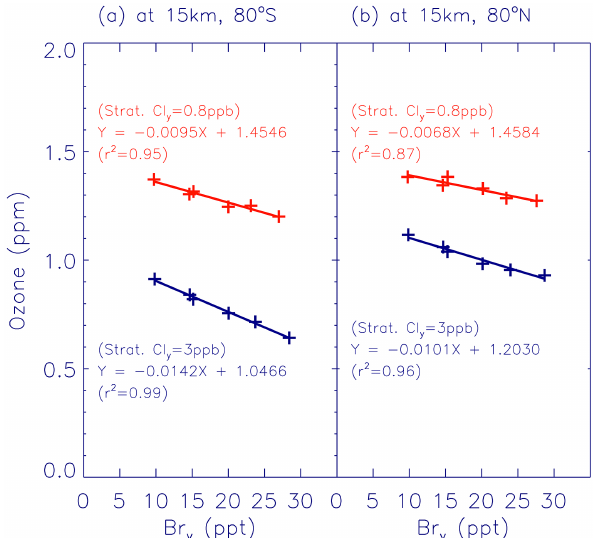
Figure 2. Relationship between stratospheric ozone concentrations and Br y at ∼ 15km and (a) 80 ◦ S and (b) 80 ◦ N. Straight lines have been fitted for each Cl y concentration (red: Cl y = 0.8ppb; blue: Cl y = 3ppb), and the quality of the fit is indicated by the correlation coefficient ( r 2 ) .